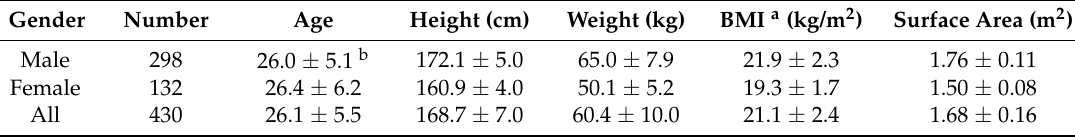
Table 1. The anthropometric information of the investigated occupants.